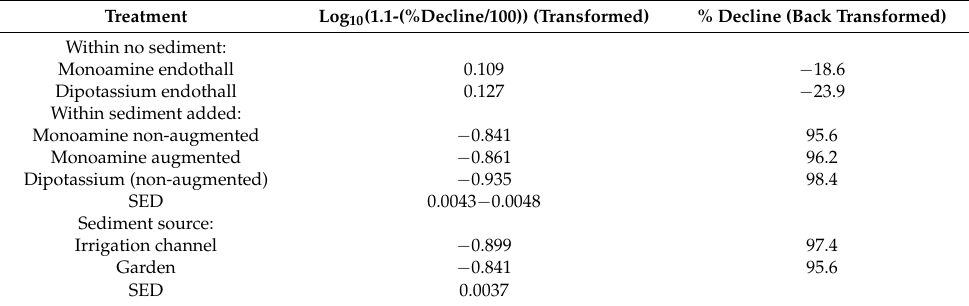
Table 6. Effect of endothall formulation and microbe augmentation, with and without sediment, and of sediment source on endothall isomer-1 concentration at day-21, as % decline from isomer-1 at day-0. A negative % decline is a percentage increase. Treatment 14 is excluded from analysis (% decline concentrations for 3 replicates of treatment 14: − 13.0, 17.1 and 31.5). SED = Standard error of the difference.